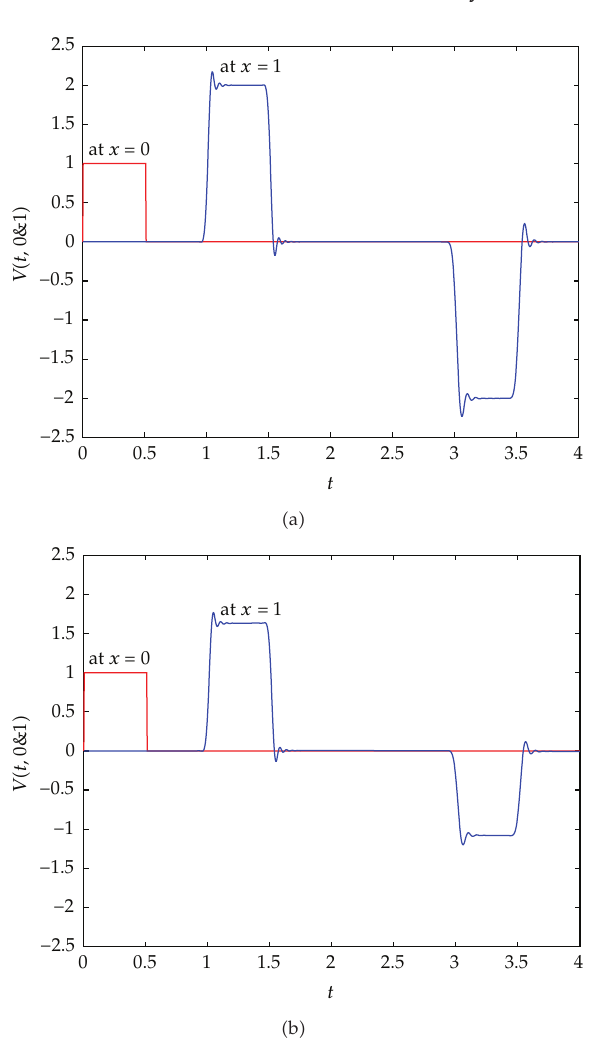
Figure 7: (cid:3) a (cid:4) The receiving- and sending-end voltages of the line in the case of slight loss. (cid:3) b (cid:4) The receiving- and sending-end voltages of the line in the case of strong